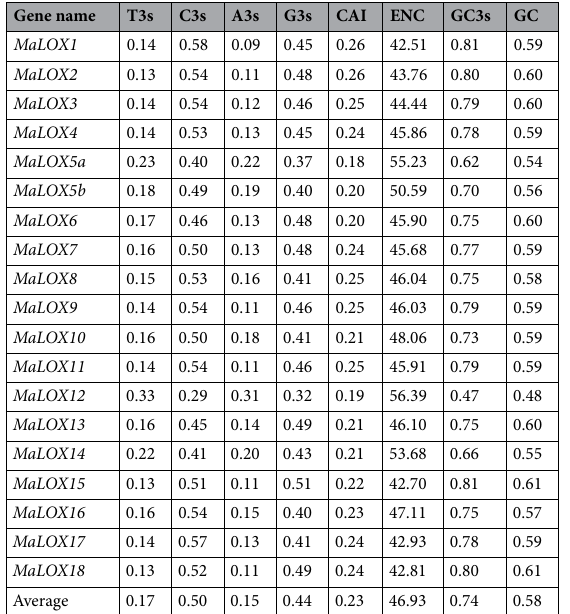
Table 3. Codon preference parameters of MaLOX family genes. T3s, C3s, A3s, G3s, and GC3s indicate that the third base of the codon is the content of T, C, A, G, and G + C. GC: total GC content in of CDS. CAI: codon adaptation index. ENC: effective number of